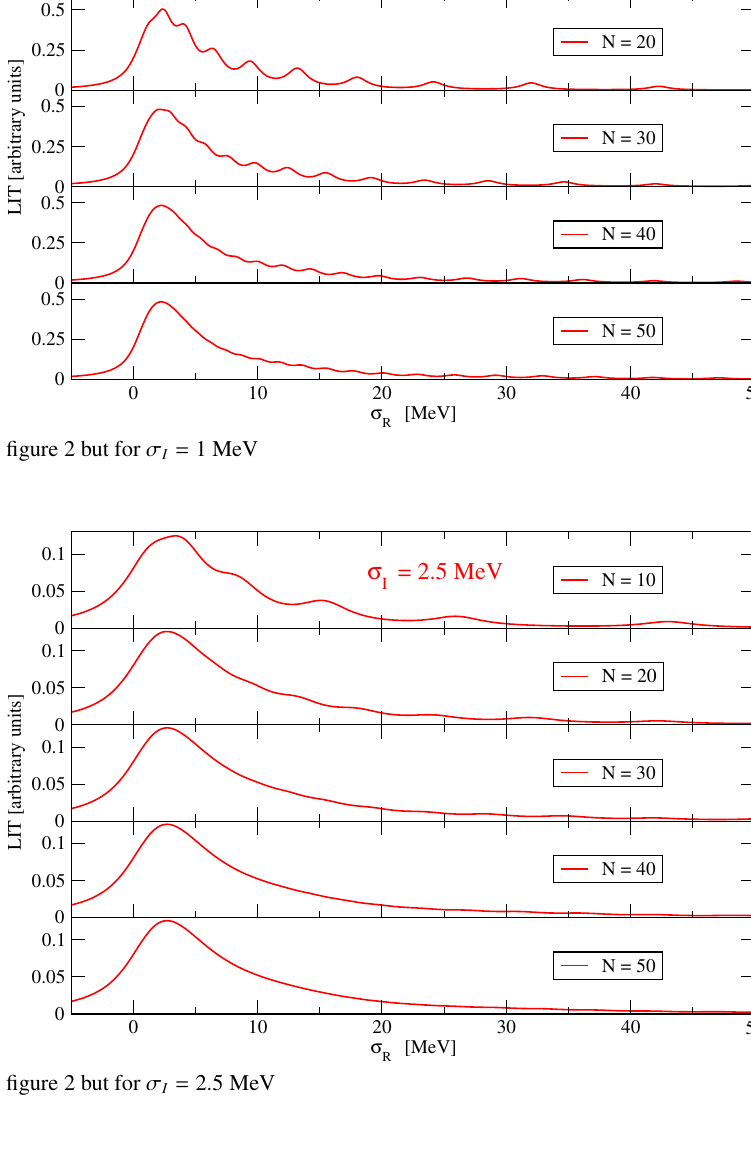
so-called Lanczos responses R Lanczos which have the